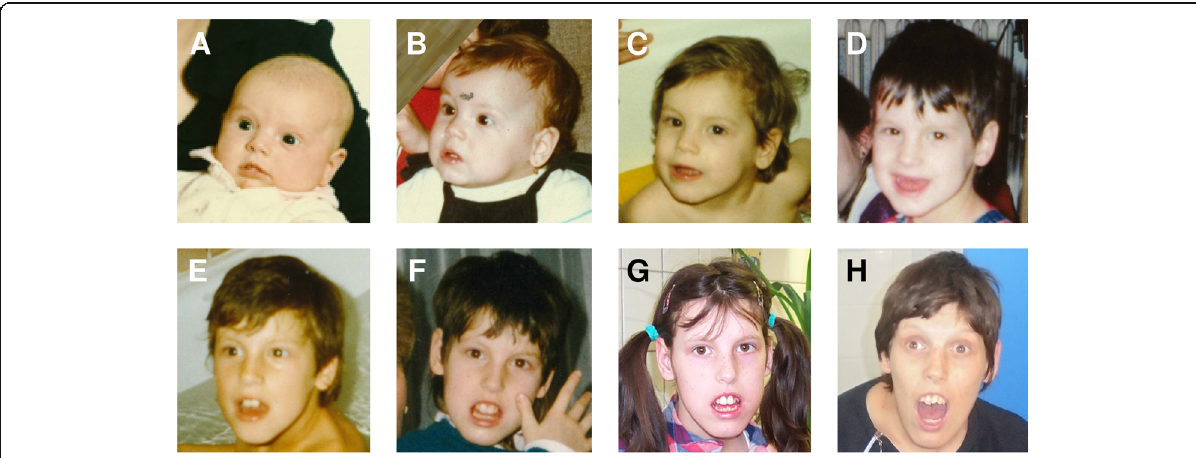
Fig. 1 Facial photographs of the patient at the age of 1 month ( a ), 1 year ( b ), 3 years ( c ), 5 years ( d ), 7 years ( e ), 10 years ( f ), 16 years ( g ), and 31 years ( h